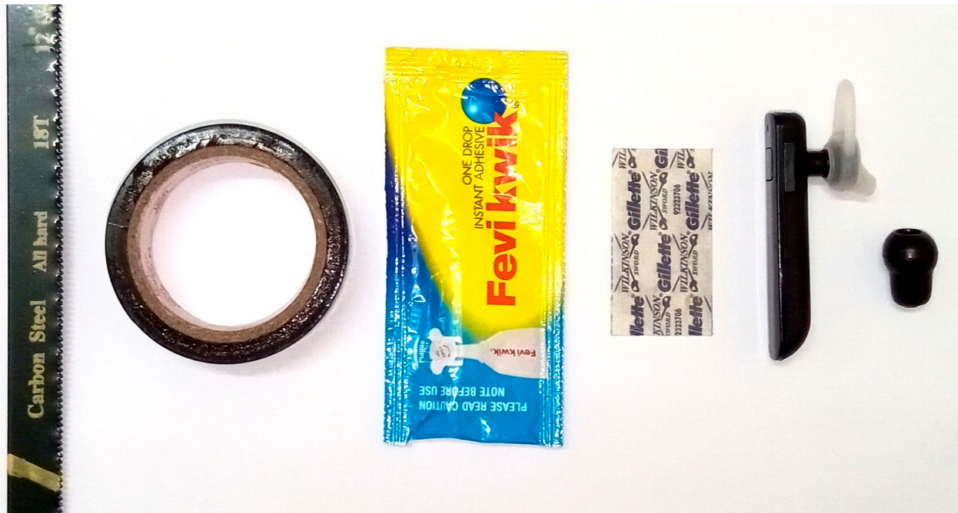
Figure 2. Materials used to transform a Bluetooth headset to a wireless phonocardiograph (From left to right: Hacksaw blade, poly vinyl carbonate (PVC) tape, instant adhesive, blade, Bluetooth headset, stethoscope ear